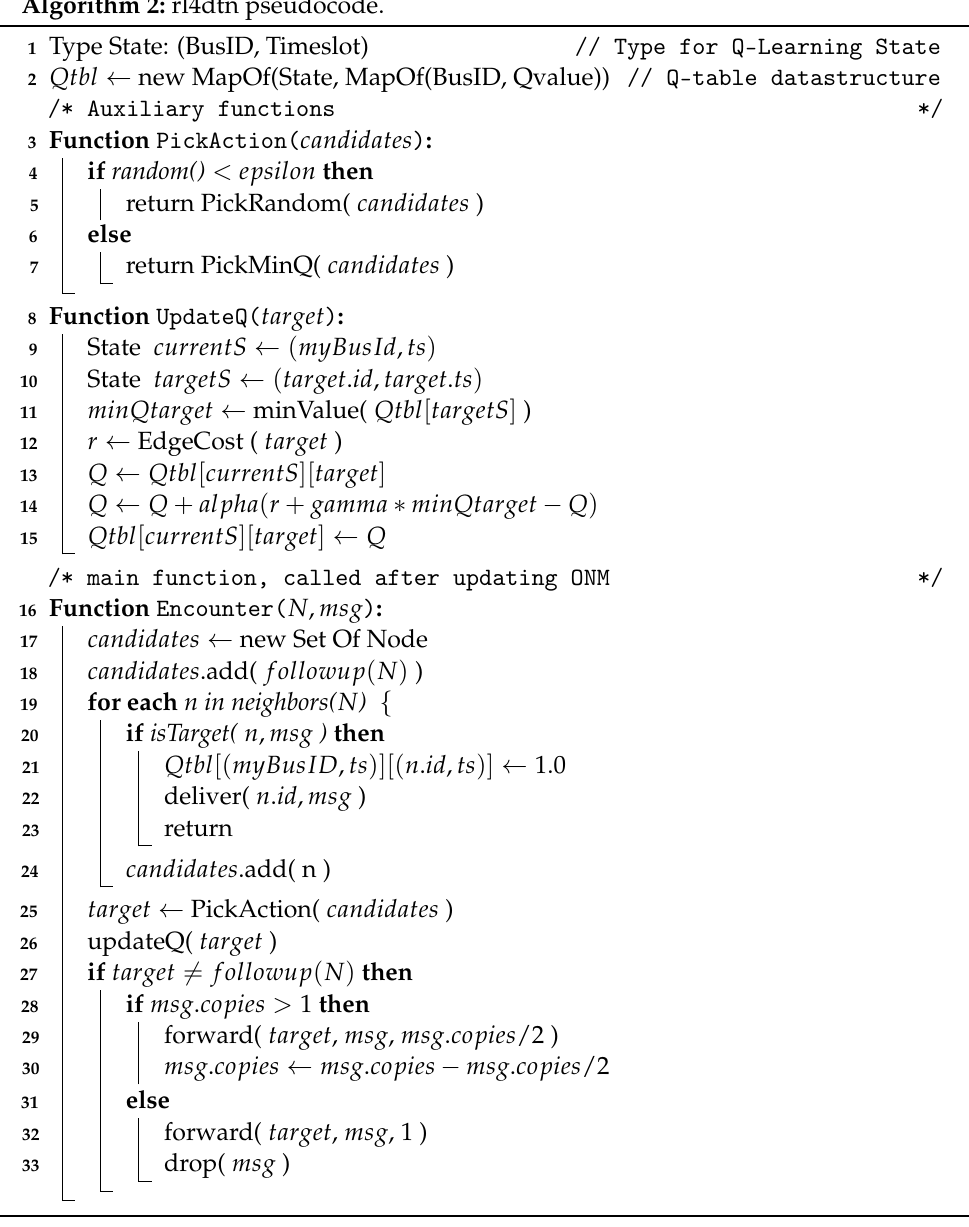
Algorithm 2: rl4dtn